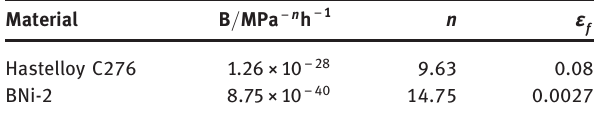
Table 1: Creep constants at 600°C.